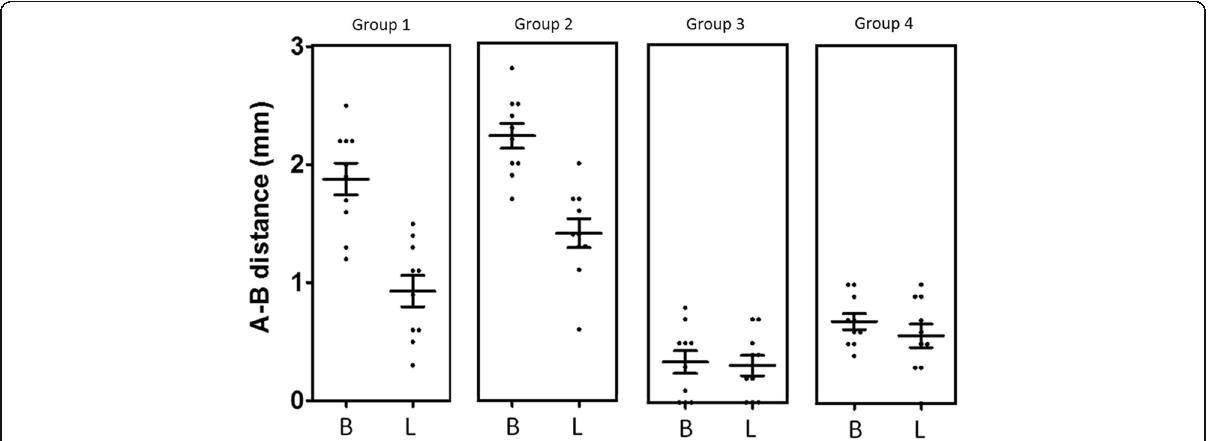
Fig. 5 Graph comparing the data of buccal (B) and lingual (L) measured the A-B distance (bone height). Group 1 = implant installed in fresh extraction and submerged; group 2 = implants in fresh extraction and immediately exposed; group 3 = implants installed in healed site and submerged; and group 4=implants in healed site and immediately